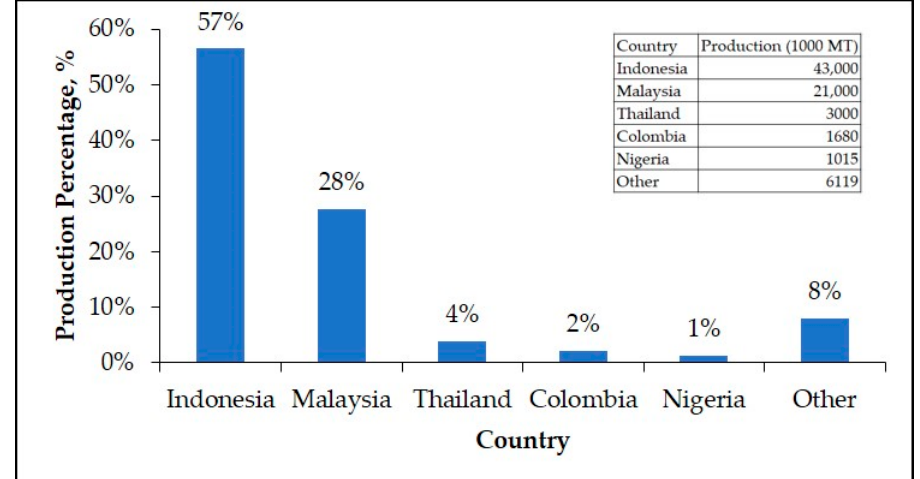
Figure 1. Comparison of palm oil production in 2019. Adapted from ref. [7].